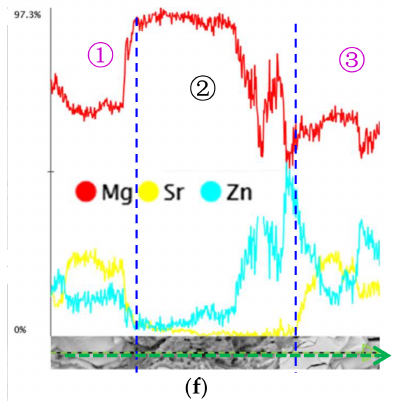
Figure 8. Fracture surfaces (backscattered electron images) of the BDF ZK40-xSr alloys tested in air: ( a , a1 ) ZK40; ( b , b1 ) ZK40-0.4Sr; ( c , c1 ) ZK40-0.8Sr; ( d , d1 ) ZK40-1.2Sr; ( e , e1 ) ZK40-1.6Sr; ( f )